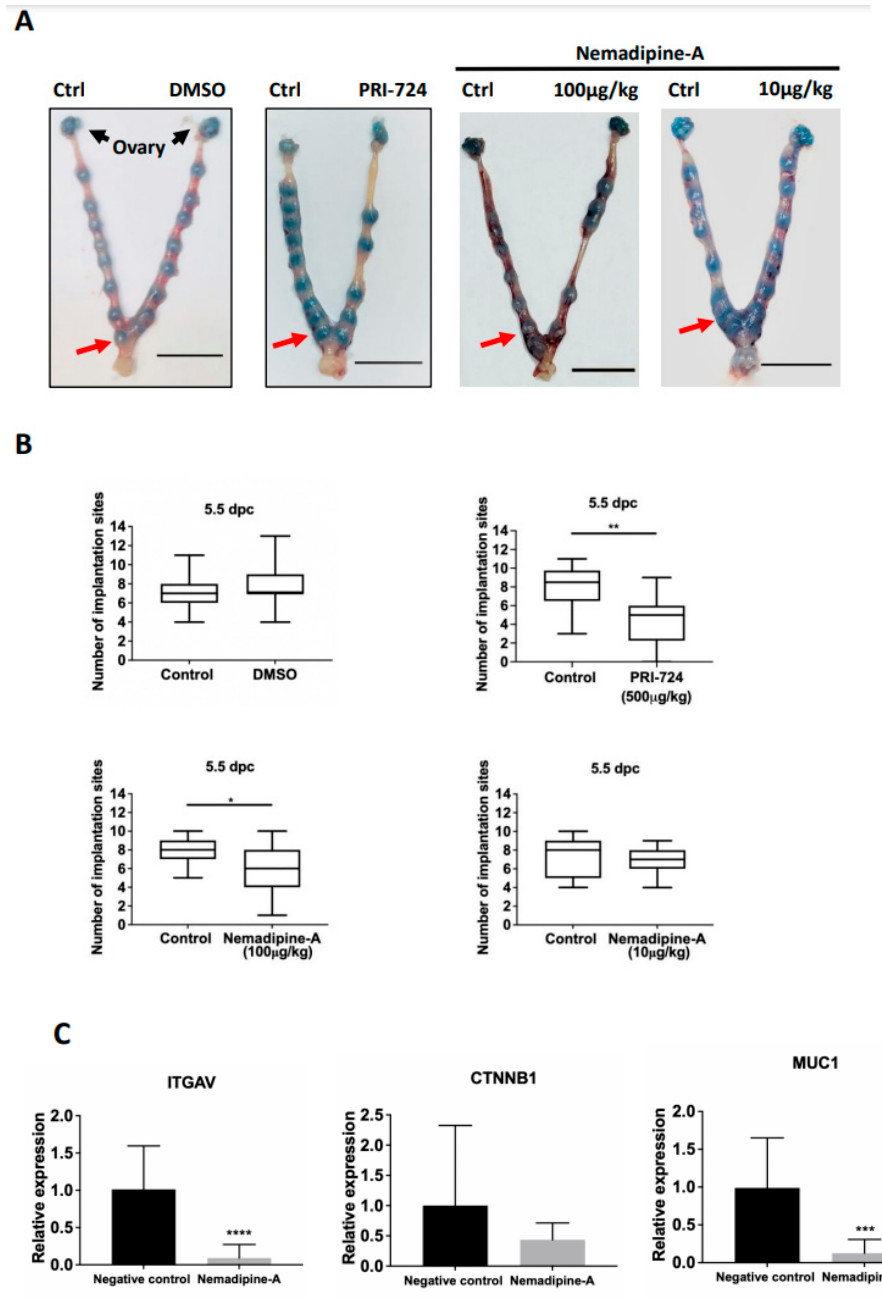
Figure 4. The effect of Nemadipine-A on embryo implantation in mice and changes in the expression of endometrial receptivity genes. ( A ) Representative images of mice uteri at 5.5 dpc after injection with 3 µ L DMSO, PRI-724, and Nemadipine-A (10 and 100 µ g/kg) at 1.5 dpc. The number of implantation sites (red arrow) at 5.5 dpc was counted via tail vein injection of Chicago blue (Scale bars = 1 cm). ( B ) The number of implantation sites on the Nemadipine-A-treated and control sides at 5.5 dpc was measured. Data are presented as median (2.5–9.75th percentile). * and ** denote p < 0.05 and <0.01 in Wilcoxon matched-pairs signed-rank test compared to the control ( n = 11–12). ( C ) Quantitative PCR analysis of the expression of ITGAV , CTNNB1 , and MUC1 transcripts in endometrial epithelium from 2.5 dpc ICR mice after transcervical transfer of Nemadipine-A (100 µ g/kg) for 24 h. Data are represented as mean ± SD. *** and **** denote p < 0.001 and <0.0001 in the Mann–Whitney U test compared to the control ( n = 3–4).